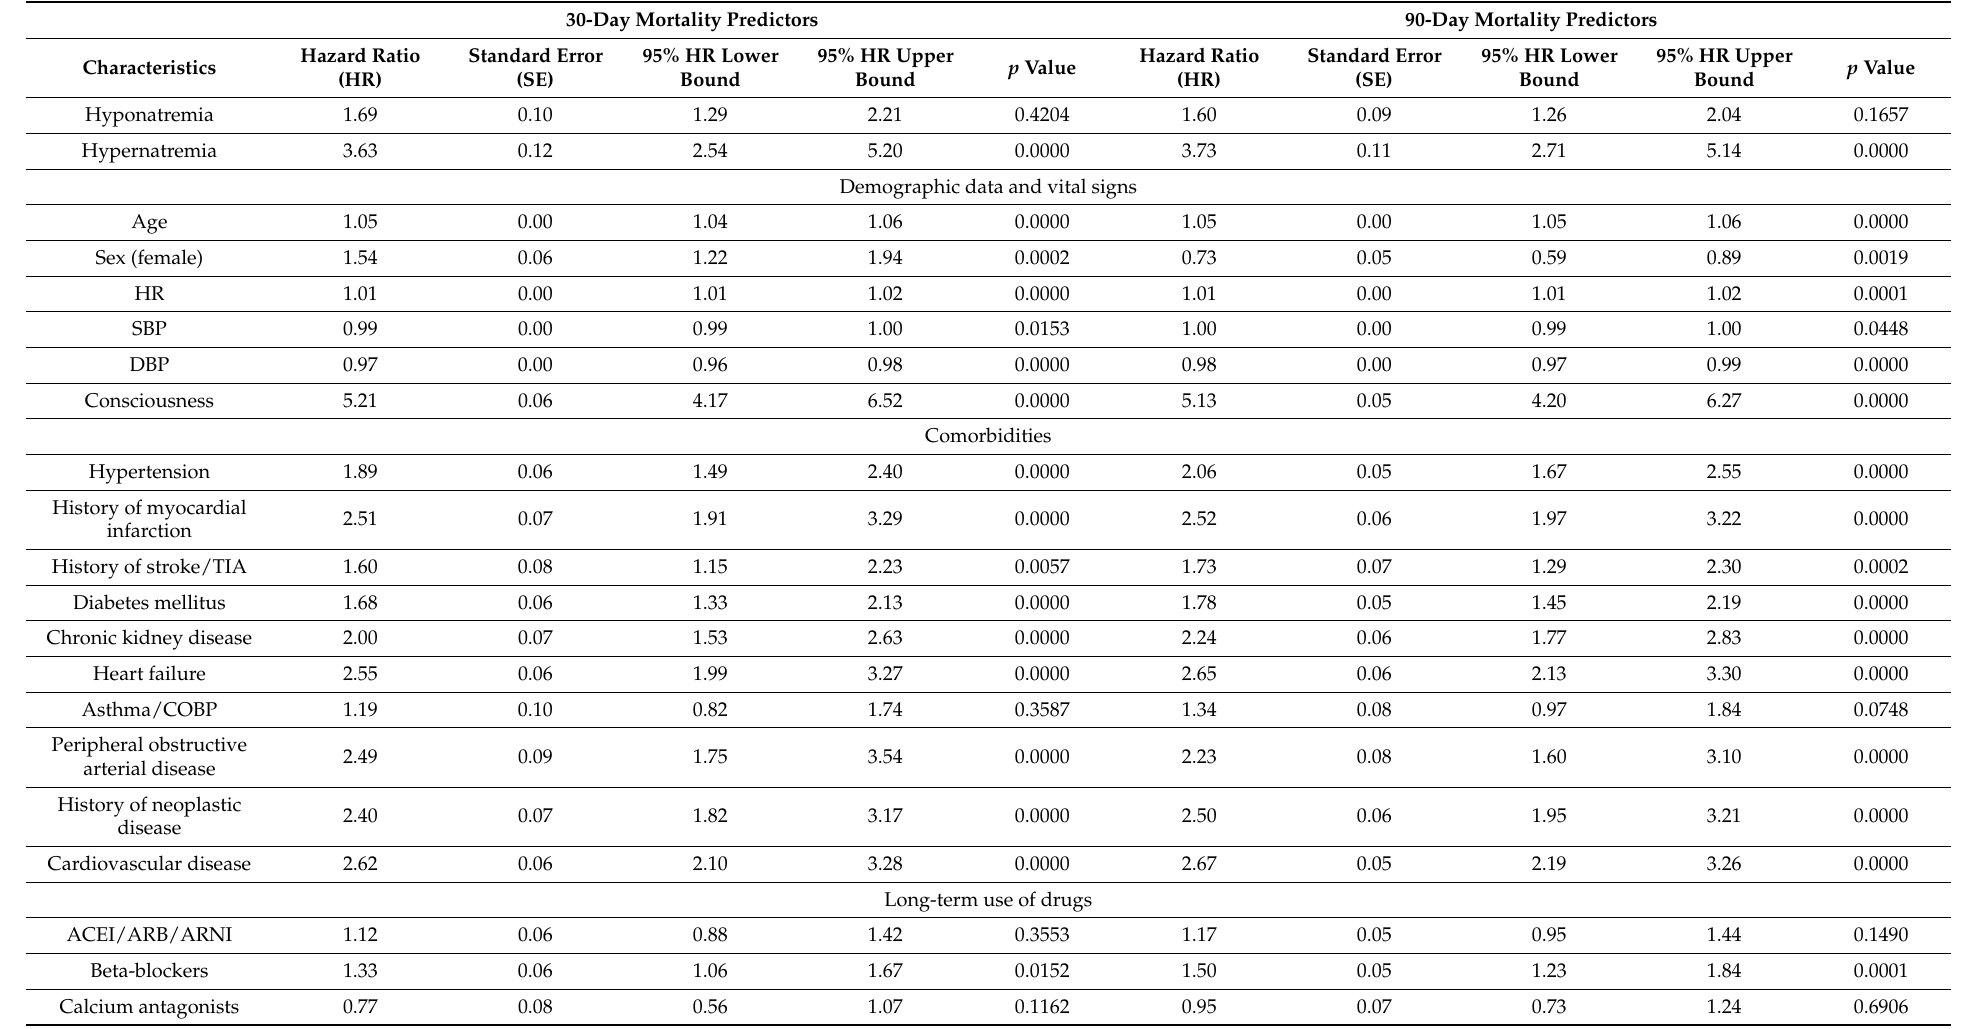
Table 2. Results of the univariate analysis of 30- and 90-day mortality predictors. See the Section 2.4 for details on the multivariate model. 30-Day Mortality Predictors 90-Day Mortality